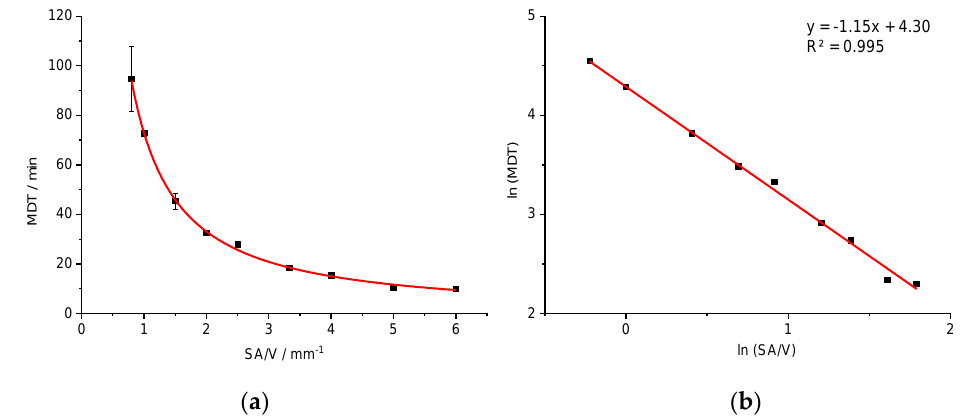
Figure 5. Correlation of MDT and SA/V ratio for the PVA-PZQ formulation ( a ) and linearized version ( b ) ( n ≥ 3; x ± s).